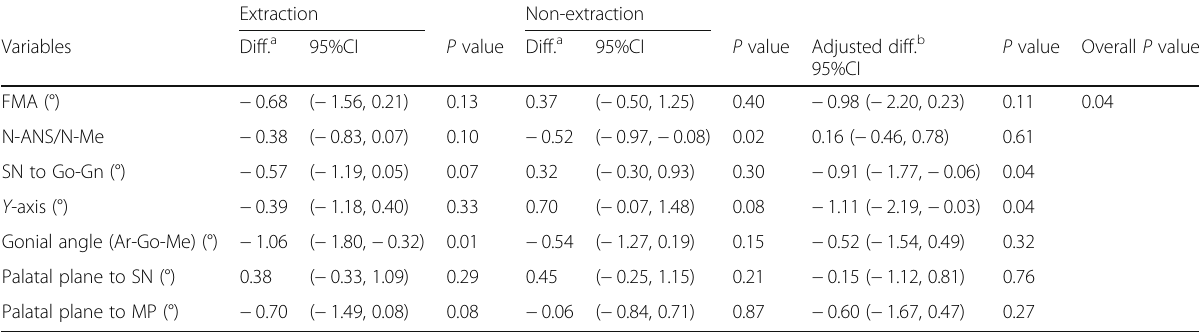
Table 2 Comparisons of intra- and intergroup differences between the two treatment groups Extraction